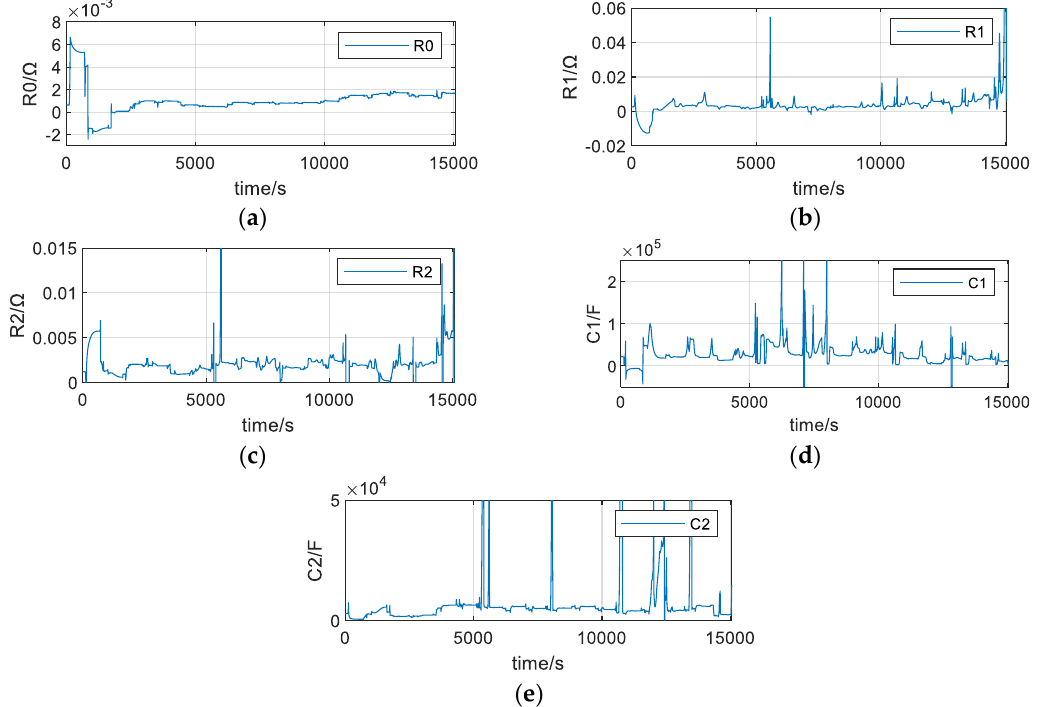
Figure 9. Parameter identification results of the AFFRLS algorithm: ( a ) Identification curve of R 0 ; ( b ) Identification curve of R 1 ; ( c ) Identification curve of R 2 ; ( d ) Identification curve of C 1 ; ( e ) Identification curve of C 2 .